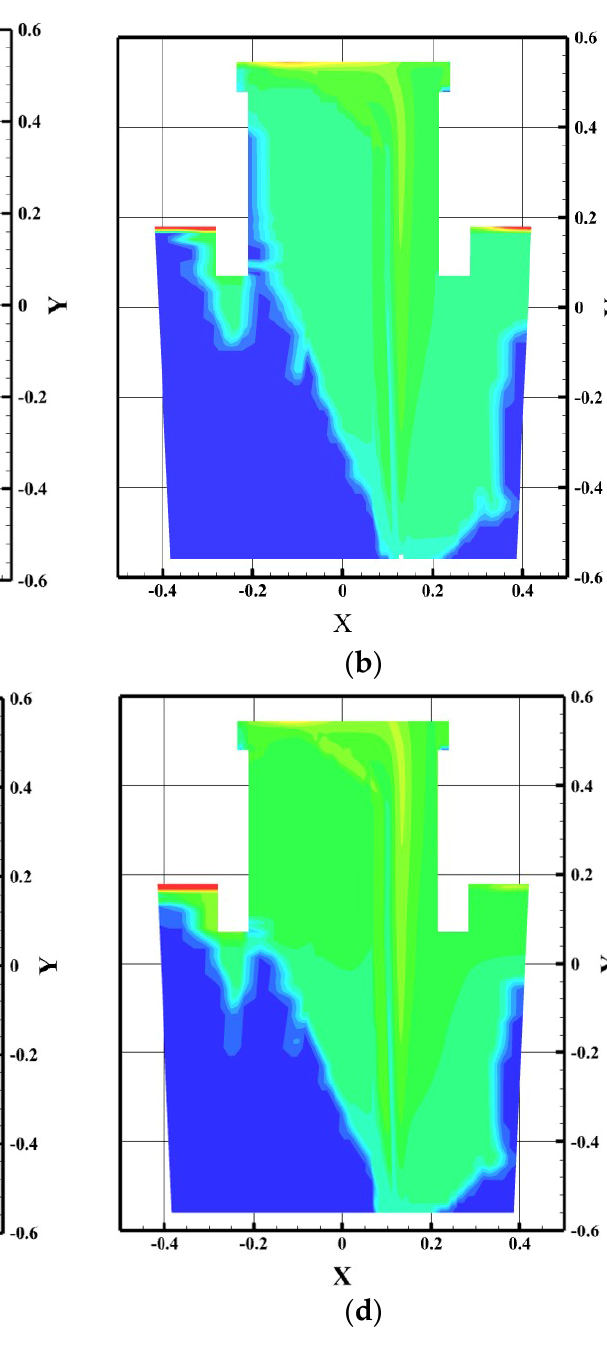
Figure 8. Distribution of bubble size diameter out of Z = 0 plane: ( a ) 360 NL/h; ( b ) 720 NL/h; ( c ) 900 NL/h; ( d ) 1080 NL/h.